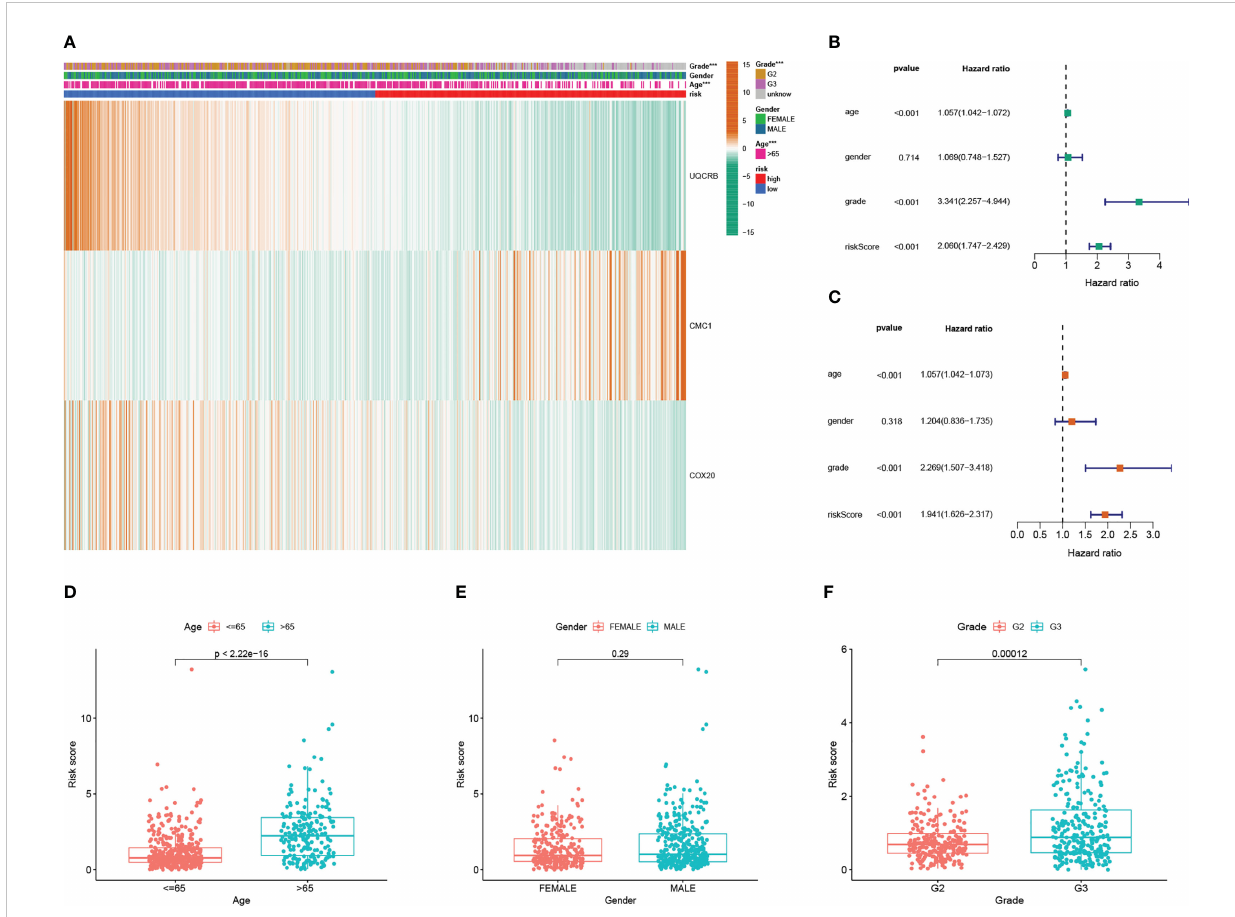
FIGURE 6 Mitochondrial-associated differential gene prognostic model in clinicopathological performance and independent prognostic analysis (A) Heat map of prognostic model and clinicopathological performance in TCGA database; (B) TCGA univariate Cox analysis and independent prognostic analysis of clinicopathology; (C) multifactorial Cox regression analysis and independent prognostic analysis of clinicopathology; (D) differential relationship between age clinical traits in risk group; (E) differential relationship between sex clinical traits in risk group; (F) differential relationship between staged clinical traits in risk